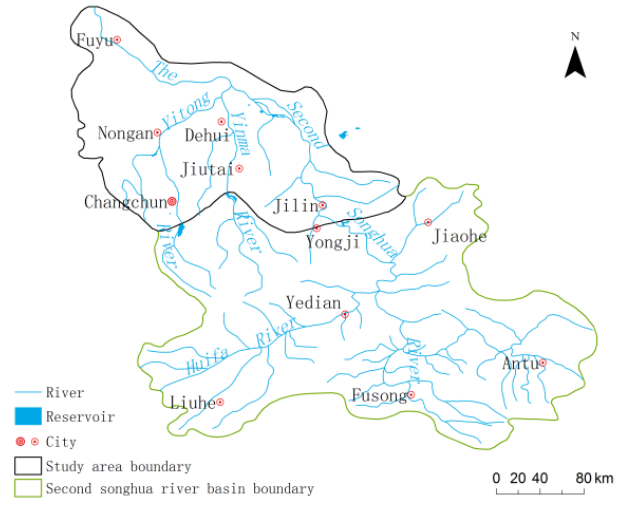
Figure 1. The Second Songhua River catchment.